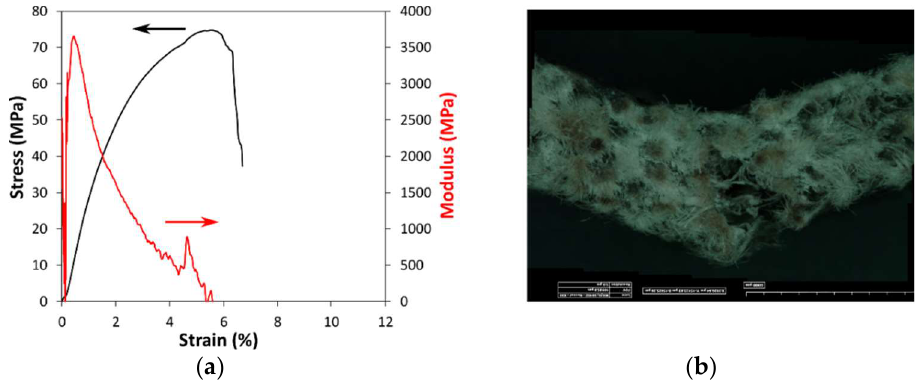
Figure 2. ( a ) Stress and modulus vs. strain plot and ( b ) related 3D optical image of the flexural fracture surfaces of unaged NFRC (i.e., FW0D0 samples).